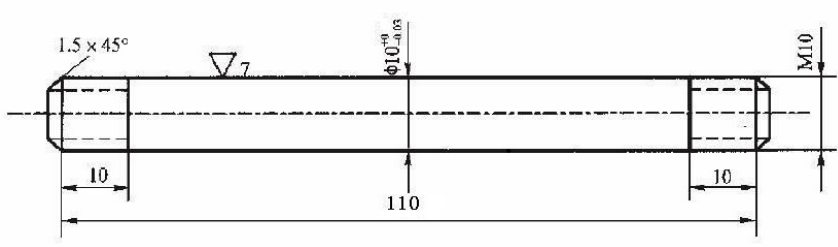
Figure 1. Dimensions (mm) of high-temperature tensile specimens.